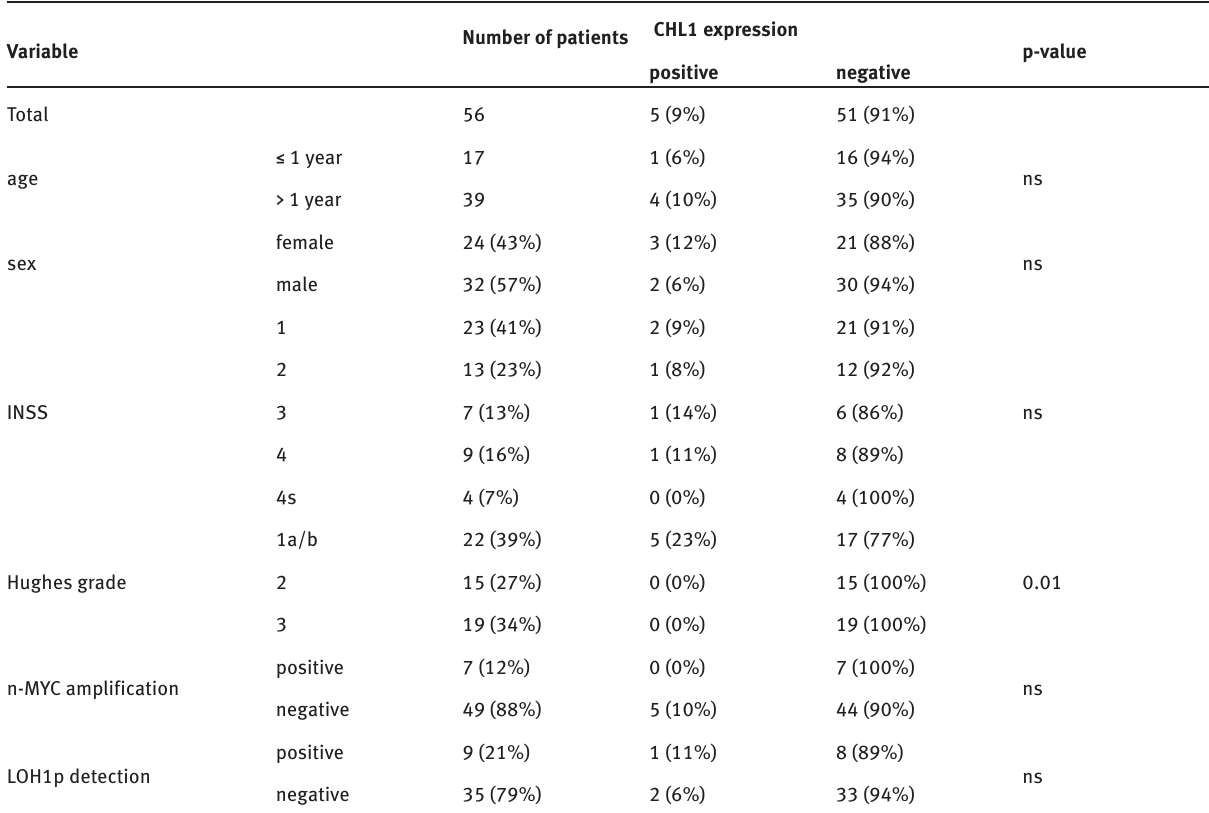
Table 1: CHL1 expression as well as clinical, pathologic and molecular characteristics of the analysed neuroblastoma tissue samples. Statis- tical analyses by using cross-tables, two-sided Fisher´s and Chi-squared